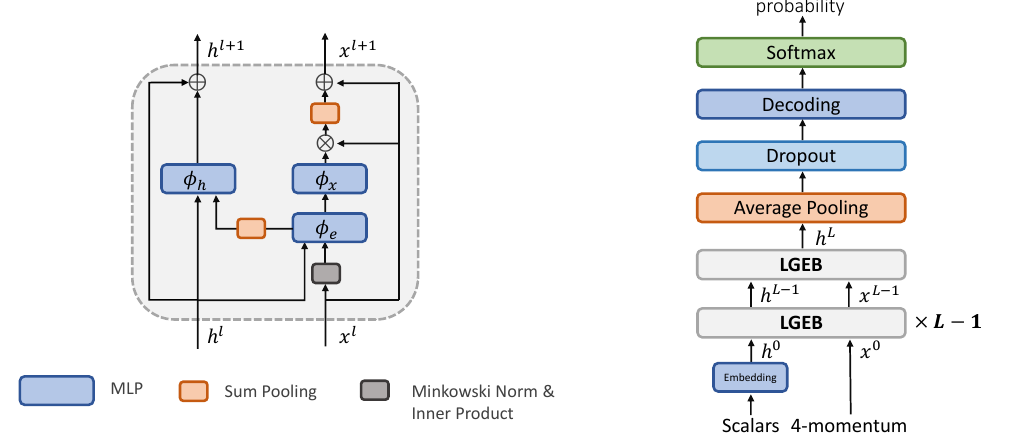
Figure 1 . ( left ): the structure of the Lorentz Group Equivariant Block (LGEB). ( right ): the network architecture of the